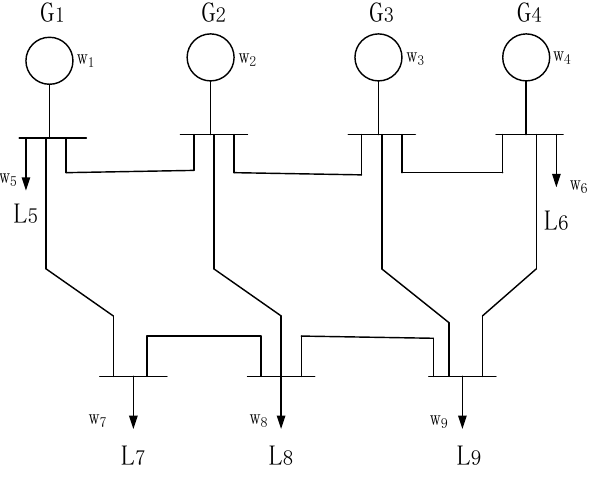
Figure 1. A four-generator and seven-bus system.